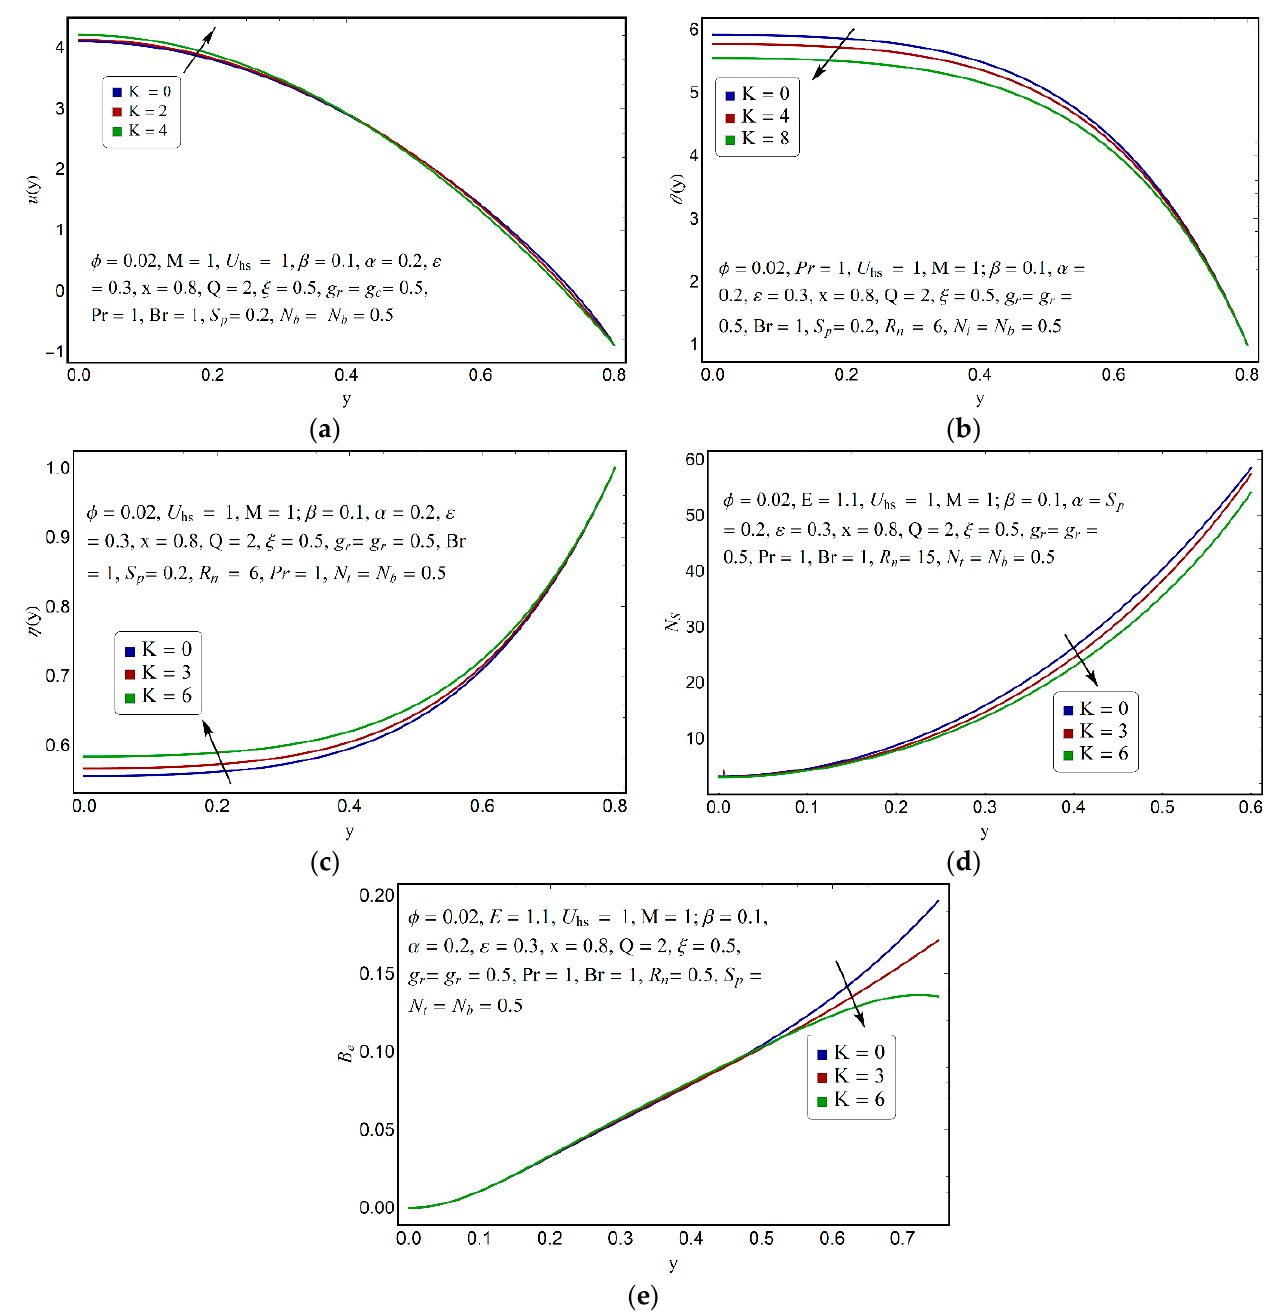
Figure 4. Impact of K on ( a ) the velocity profile, ( b ) the temperature, ( c ) the mass concentration, ( d ) the entropy number, and ( e ) the Bejan number.